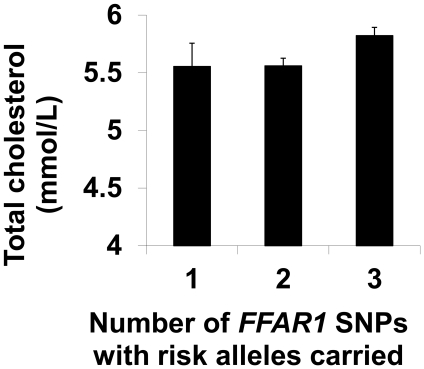
The cumulative effect of carrying risk alleles in three SNPs of FFAR1 on total cholesterol.Data presented are mean ± SEM of total cholesterol for individuals according to the number of SNPs for which risk alleles were present. Each SNP in the FFAR1 region which was examined (rs2301151; rs1573611; rs16970264) was scored 0 or 1 based on the presence of risk alleles (dominant model). The number of SNPs with risk alleles was summed. All individuals had at least 1 SNP with risk alleles present. There was a cumulative effect on total cholesterol of 0.18±0.08 mmol/L per SNP, P = 0.03 assessed by linear regression analysis with age, gender and BMI. This was not statistically significant when accounting for multiple comparisons by the Benjamini and Hochberg False Discovery Rate procedure with q* = 0.05.